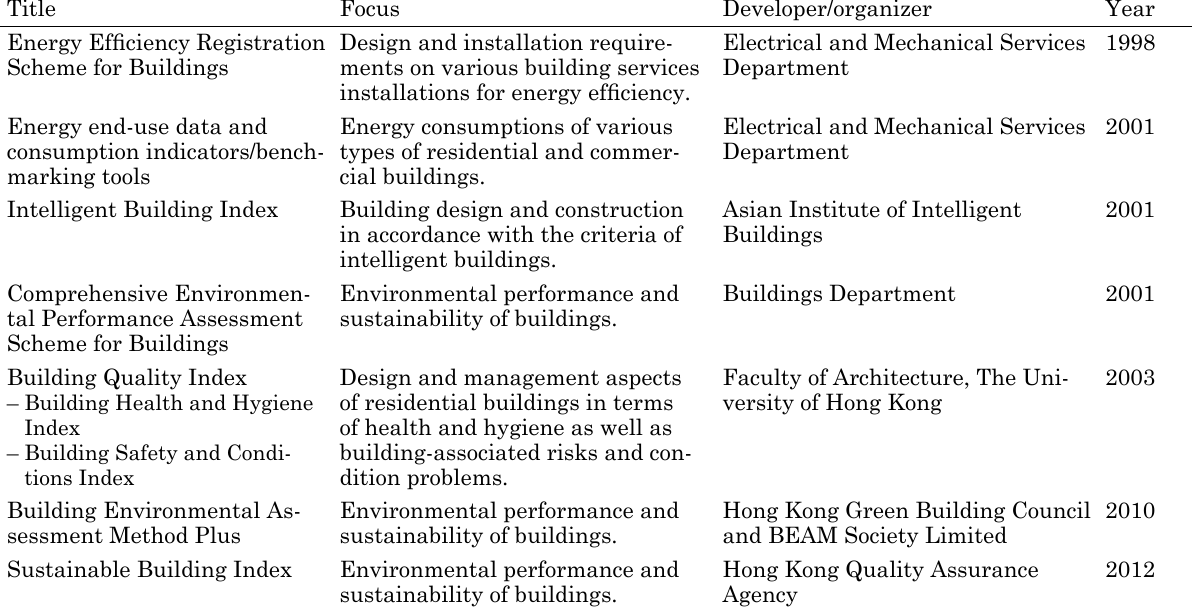
Table 2. Building-related performance evaluation schemes/tools in Hong